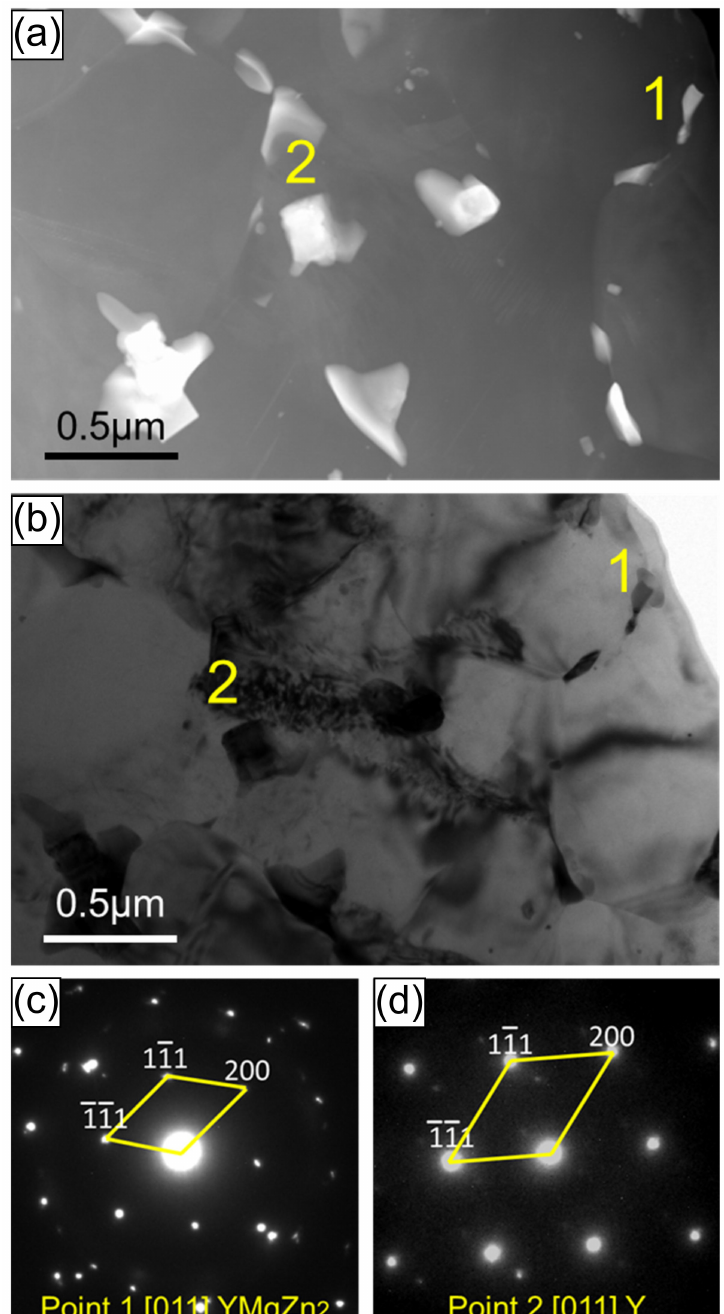
Figure 3. Scanning TEM (STEM) micrograph of the area across the di ff usion region of the ZK60 / WE43 composite. ( b ) Bright-field TEM micrograph of the same location, and the selected area electron di ff raction (SAED) pattern for ( c ) point 1 and ( d ) point 2 indicated in ( a ) and ( b ),